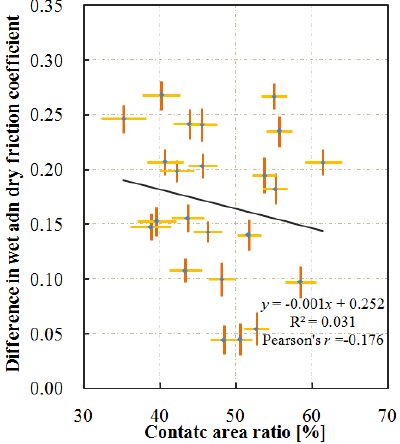
Figure 14. Effect of contact area on difference in friction coefficient. Figure 14. E ff ect of contact area on di ff erence in friction coe ffi